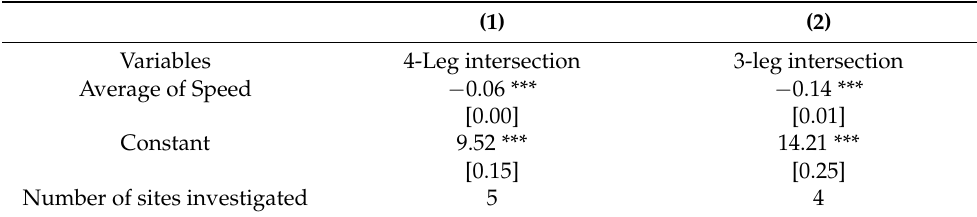
Table 5. Relationship between red light violation with